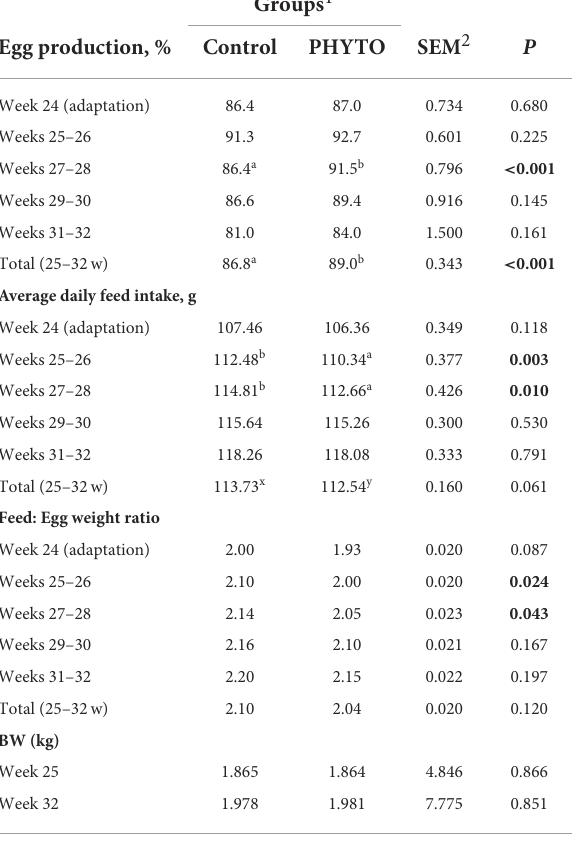
TABLE 3 Effect of dietary supplementation with PHYTO on serum biochemical parameters measured in two hens per replicate cage ( n = 50 per group) at the end of the experimental period (week